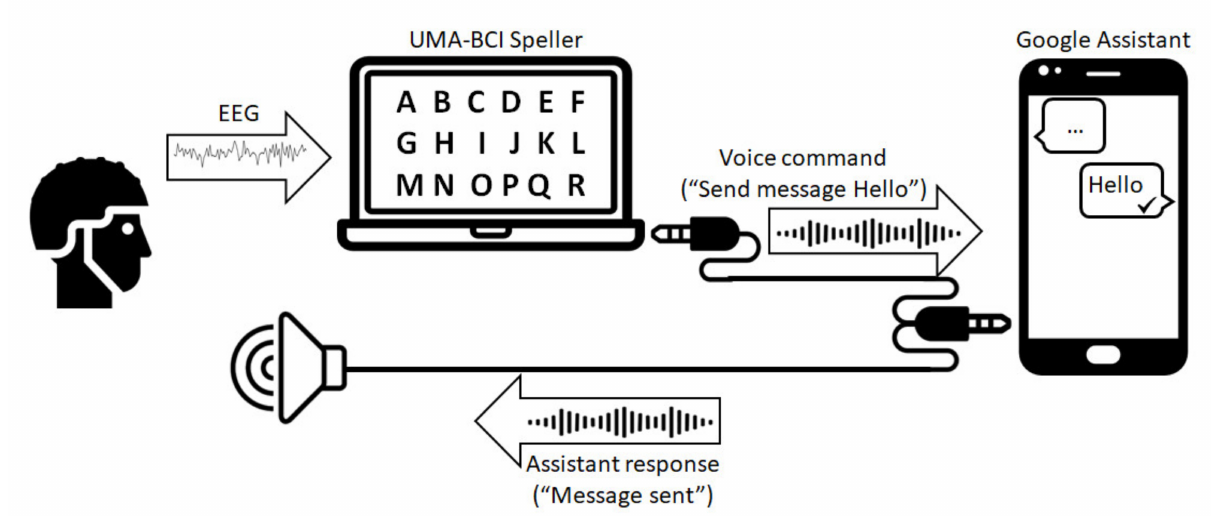
Figure 1. System implementation. By using an oddball paradigm the user can select items from a matrix to spell a command, e.g., “Send message Hello”. This text command is converted to voice in the computer and sent through an audio cable to the microphone input of a smartphone. The smartphone virtual assistant receives the command, performs the corresponding action (to send the message “Hello”, in the example), and gives audio feedback to the user (“Message sent”, in the example) through a